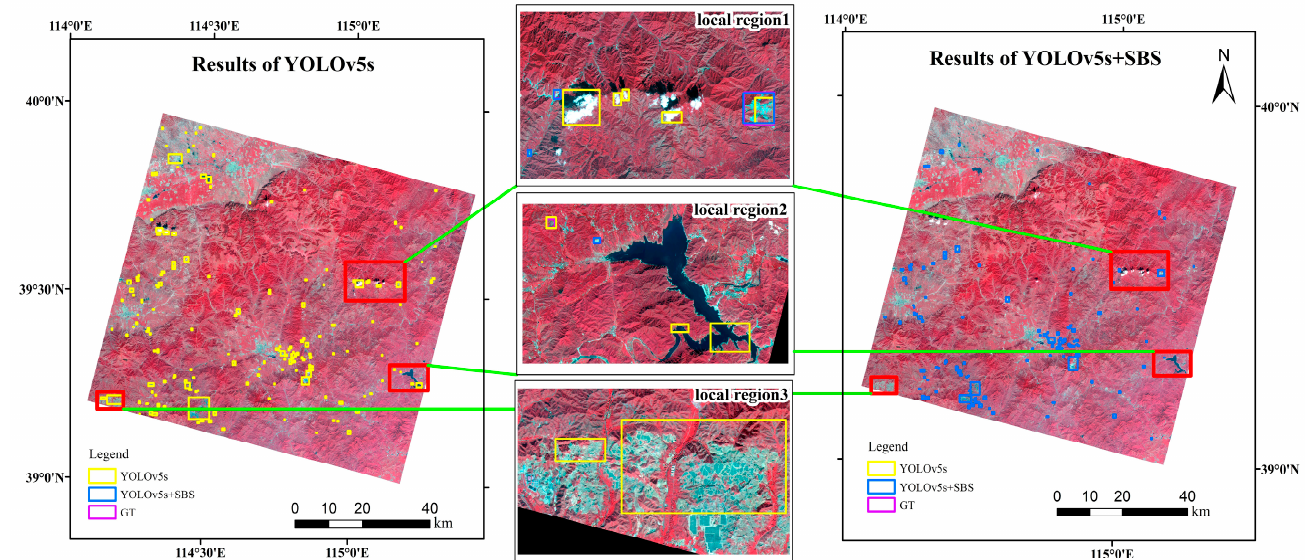
Figure 14. The qualitative results of YOLOv5s and YOLOv5s+SBS on the entire GF-6 images. The yellow detection frames are the detection result of YOLOv5s, the blue detection frames are the detection result of YOLOv5s+SBS, and the purple label frames are the ground truth.